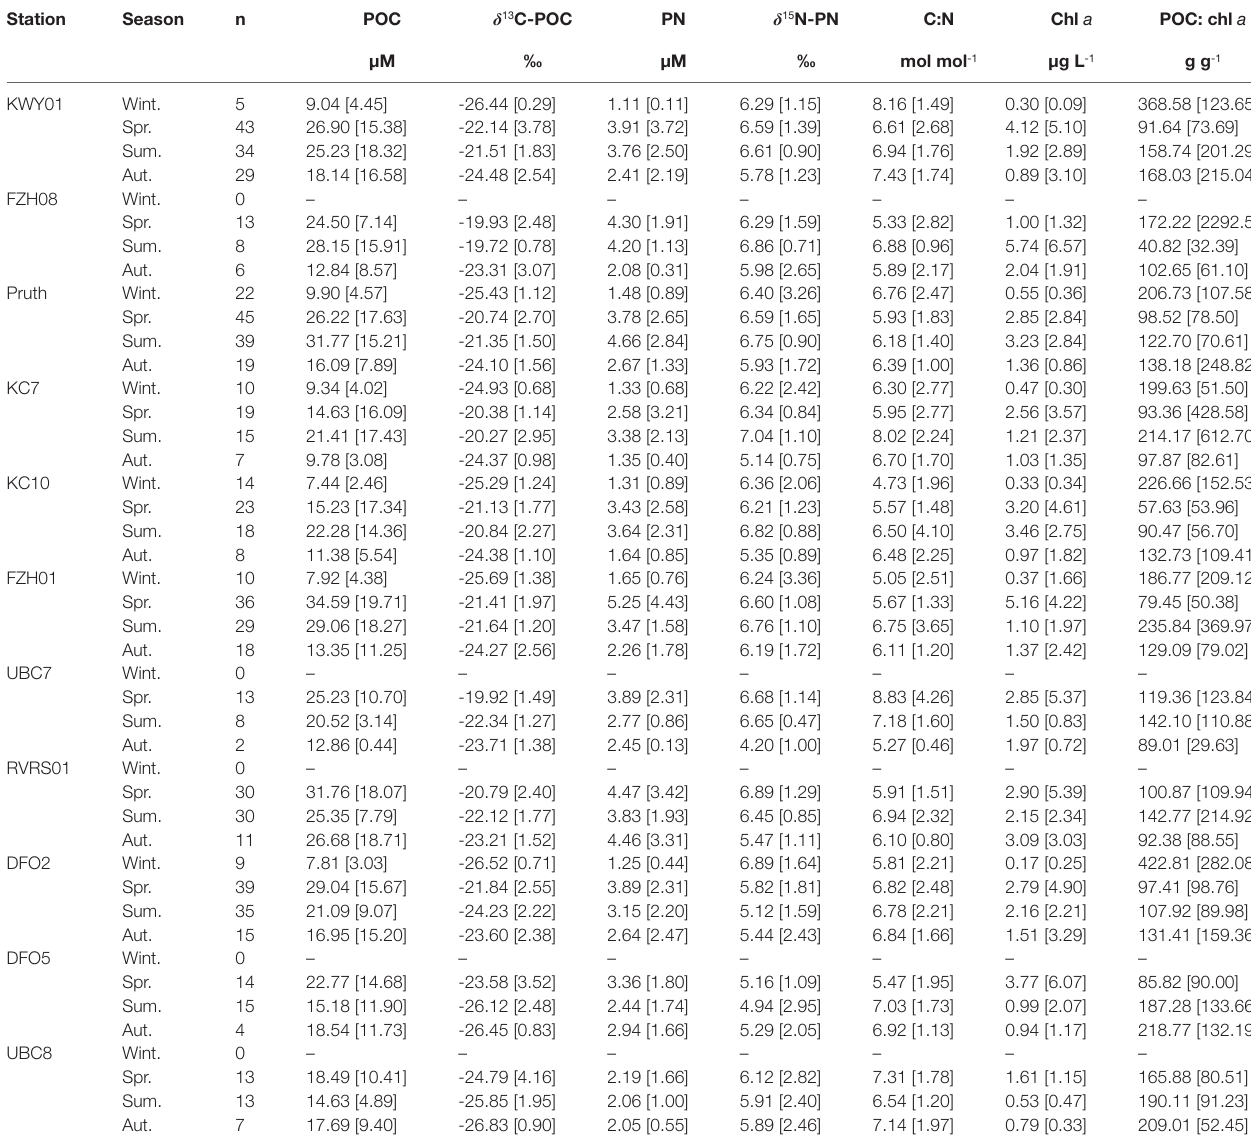
TABLE 1 | Median [interquartile range] seasonal particulate organic carbon (POC) concentration, δ 13 C-POC, particulate nitrogen (PN) concentration, δ 15 N-PN, C:N molar ratio, chlorophyll a concentration and POC:chl a ratio, where winter is Dec-Feb, spring is Mar-May, summer is Jun-Aug, autumn is Sept-Nov.